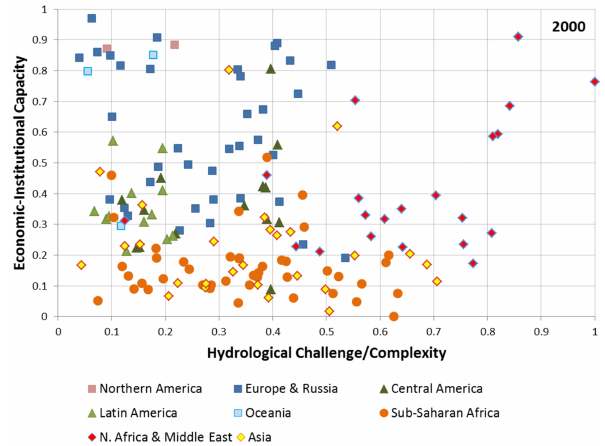
Figure A1. Hydro-economic (HE) classification of countries ac- cording to their level of hydrological complexity ( x axis) and their economic-institutional coping capacity ( y